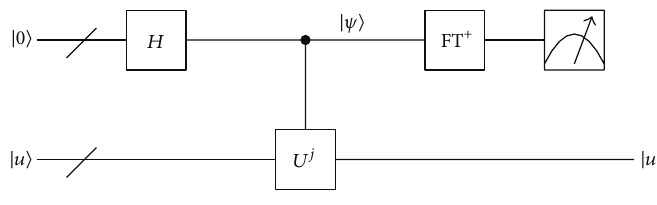
Figure 9: Schematic of the overall phase estimation procedure.